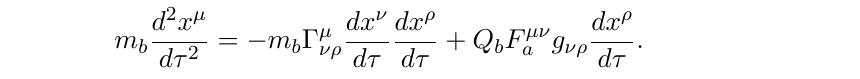
) . (b) The diagram needed for the b , Q b